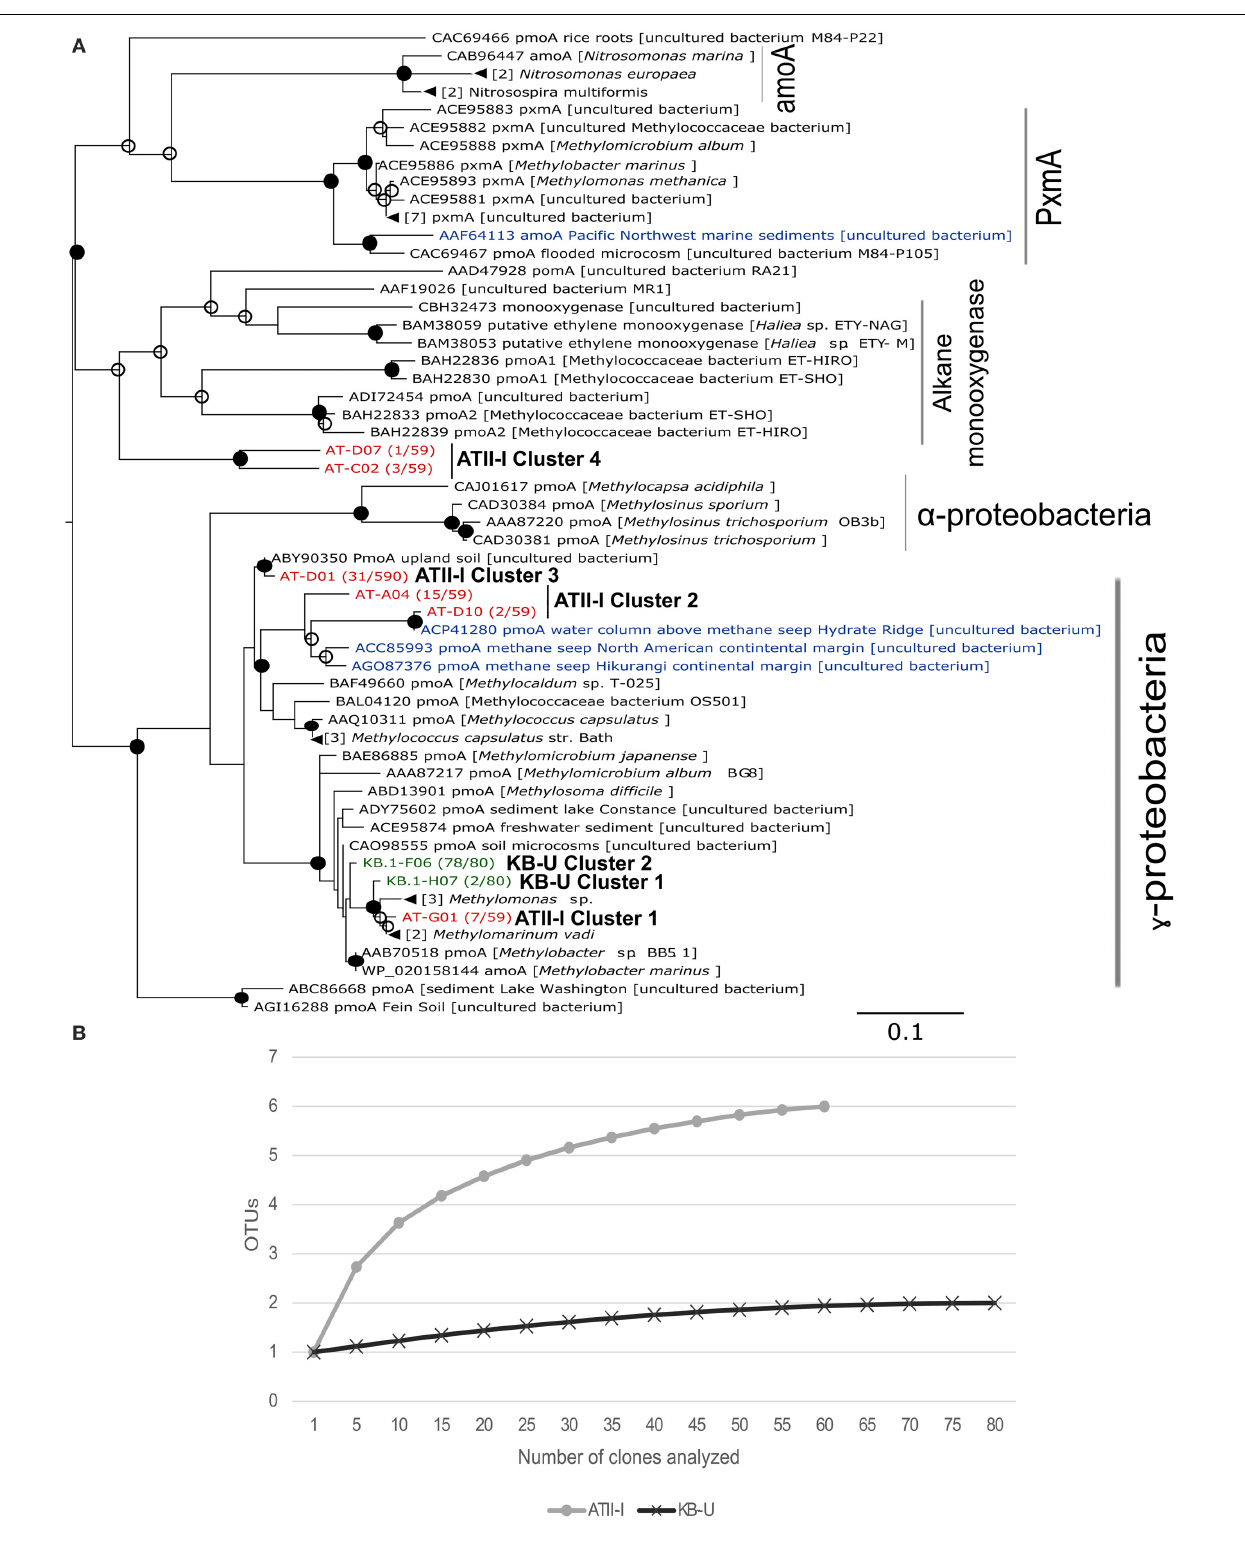
FIGURE 4 | pmoA phylogenetic tree and species richness of aerobic methanotrophs. (A) Deduced amino acid phylogeny of predicted pmoA sequences amplified from ATII-I (6 OTUs-red) and KB-U (2 OTUs-green) based on 90% nucleotide sequence identity. The Red Sea brine pool OTUs were